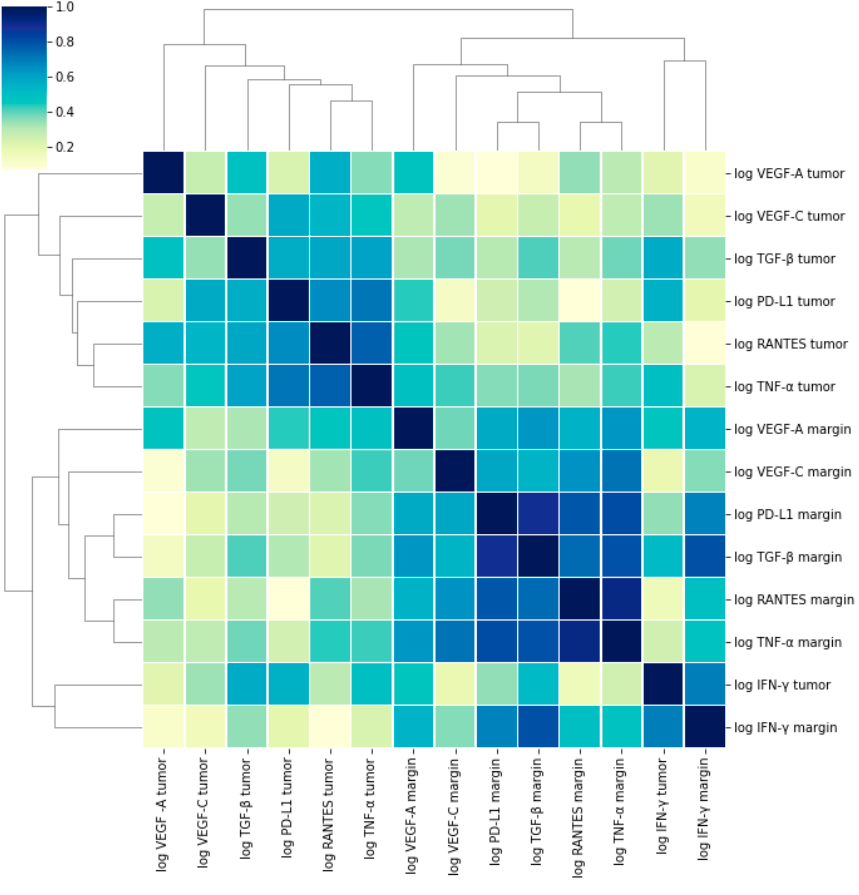
Figure 3. Correlations between the levels of the examined molecules presented as heatmap with hierarchic clustering. Table 4. Correlations between the RANTES levels and the examined molecules. R—Pearson’s cor ‐ relation coefficient.